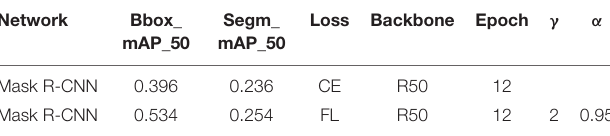
TABLE 4 | Training parameter and test results based on Mask R-CNN with different loss